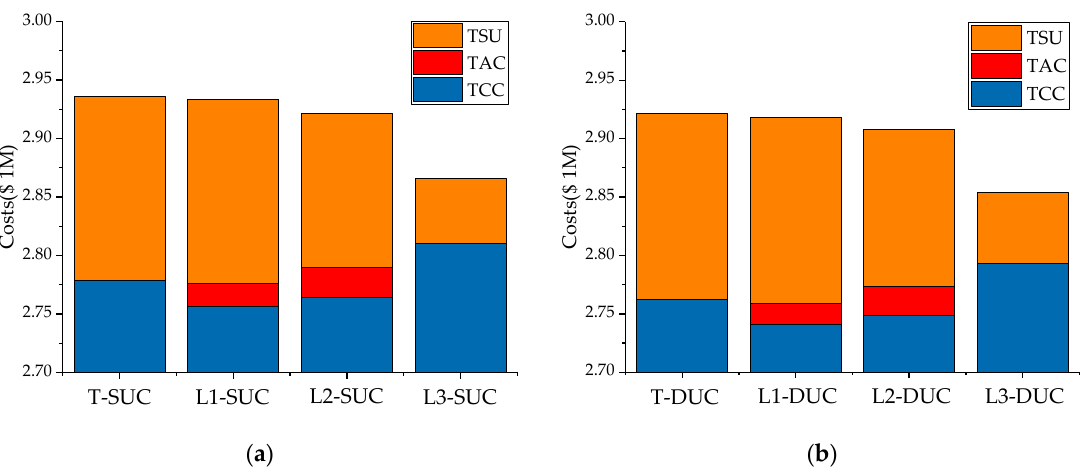
Figure 3. Column diagrams of the total operating costs: ( a ) results of different SUC formulations; ( b ) results of different DUC formulations.